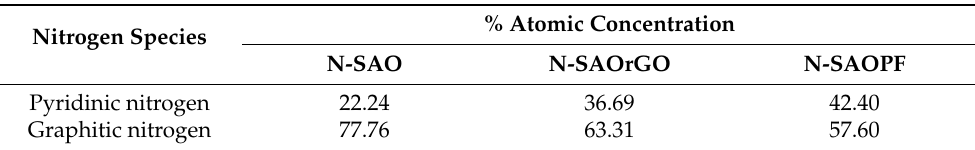
Table 2. Percentage atomic concentration of nitrogen species present in N-SAO, N-SAOrGO and